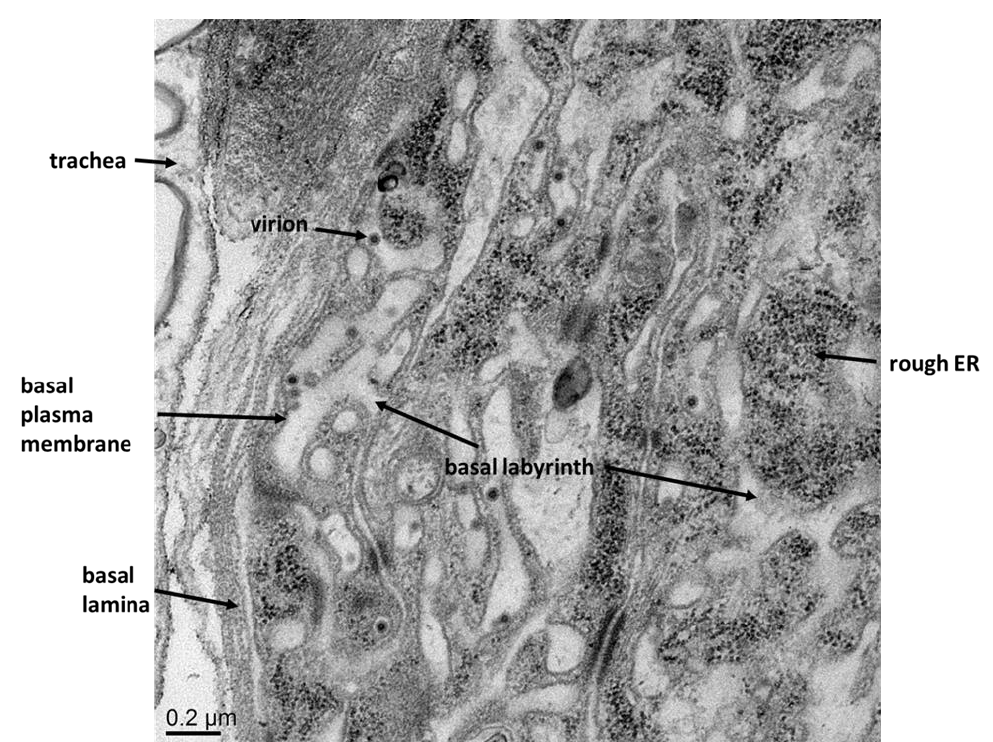
Figure 3. Ultrastructural view of the posterior midgut tissue of an Ae. aegypti female orally infected with CHIKV 37997 at 7 days post-infection. Virus titer in the bloodmeal was ~10 7 pfu/mL. CHIKV virions are present only in the basal labyrinth of the epithelial cell, which is the putative site of viral assembly. Virions are visible budding from the basal plasma membrane in close proximity to the BL. Virions crossing the BL were not observed (magnification: 8000×).